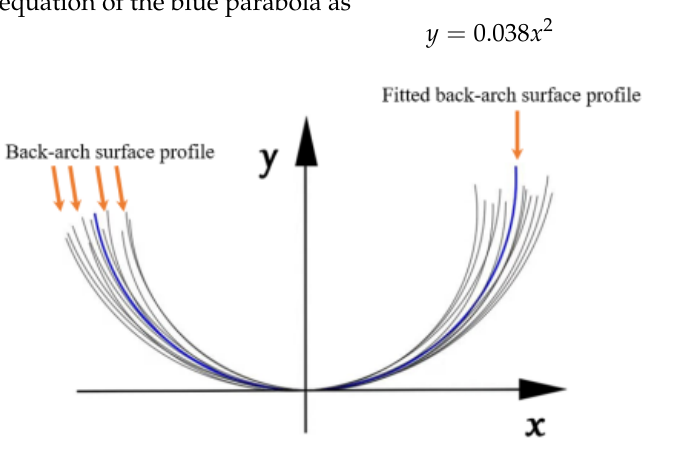
Figure 8. Arch surface contour curve of garlic.